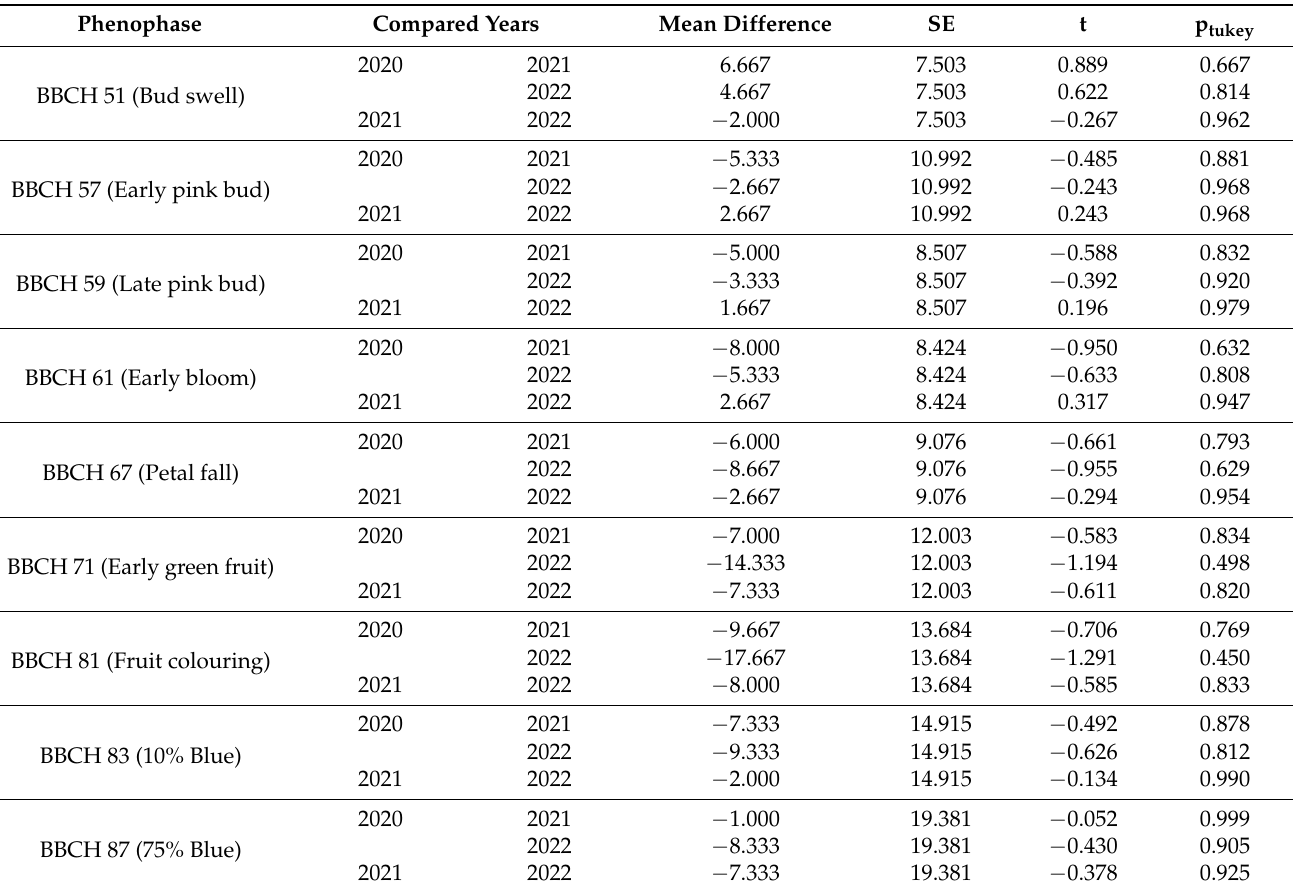
Table 5. Analysis of variance (ANOVA) on phenology under the influence of year. Phenophase Compared Years Mean